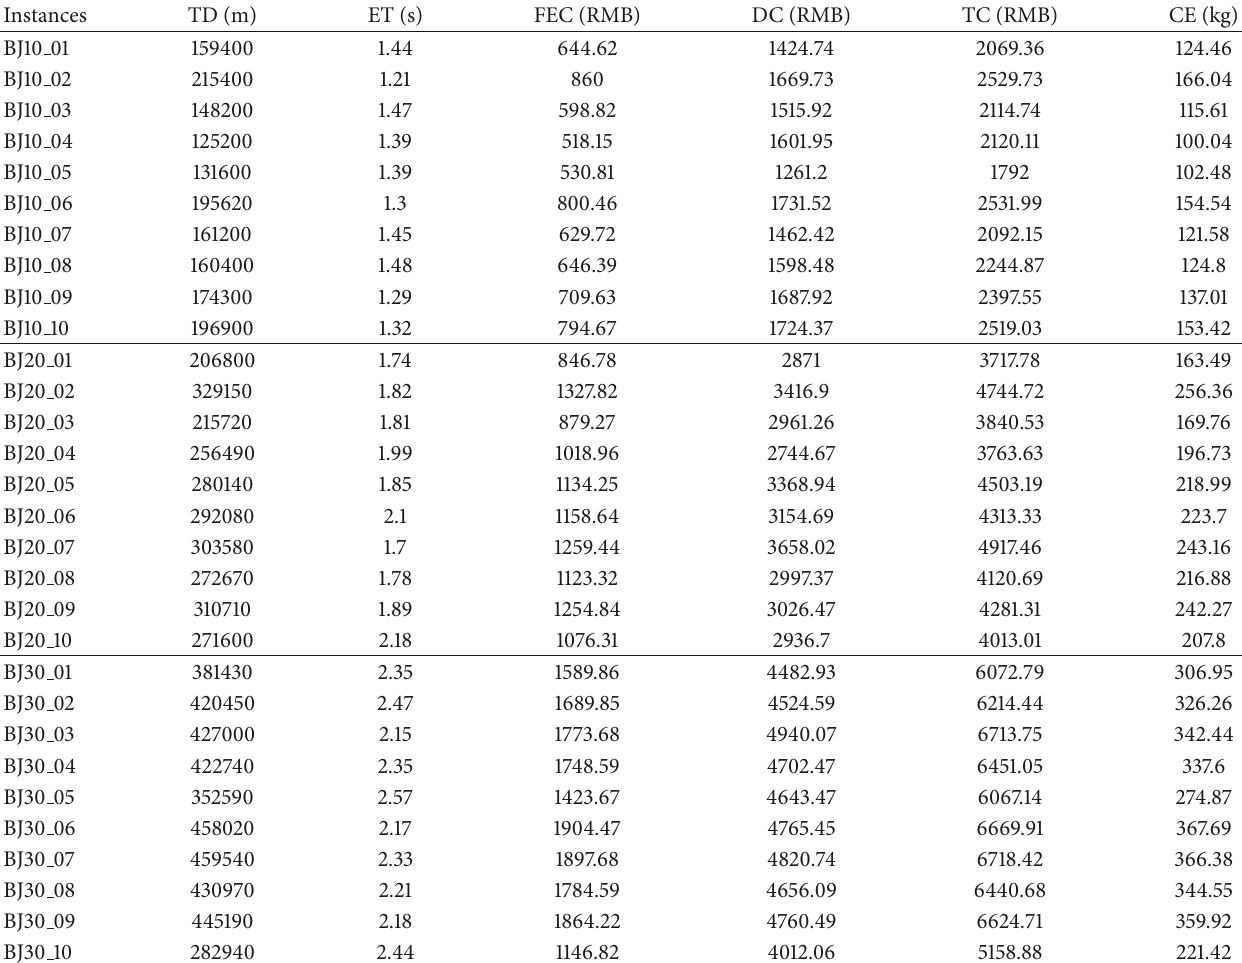
Table 6: Cost component with Min DC.